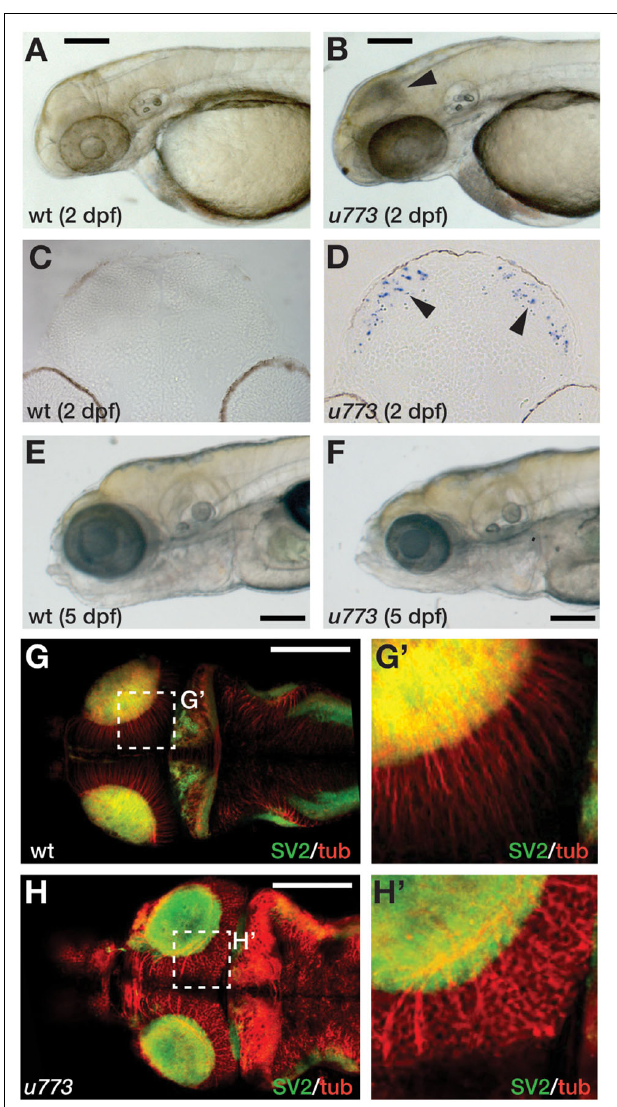
FIGURE 1 | u773 mutants show tectal apoptosis. (A,B) Lateral views of 2 dpf live wildtype (A) and u773 mutant (B) embryos. The arrowhead in (B) indicates dying tectal cells. (C,D) Transverse sections of the tecta of u773 mutants and siblings showing TUNEL labeled apoptotic cells (blue, arrowheads). (E,F) Lateral views of 5 dpf live wildtype (E) and u773 mutant (F) larvae. (G–H’) Dorsal views of brains of u773 mutants and siblings labeled with anti-acetylated tubulin (red) and SV2 antibodies showing organization of cells, processes and neuropil. (G’,H’) show magnified views of the boxes in (G) and (H) . Note that in the u773 mutant, tubulin staining is aberrant. Scale bars: 200 µ m.